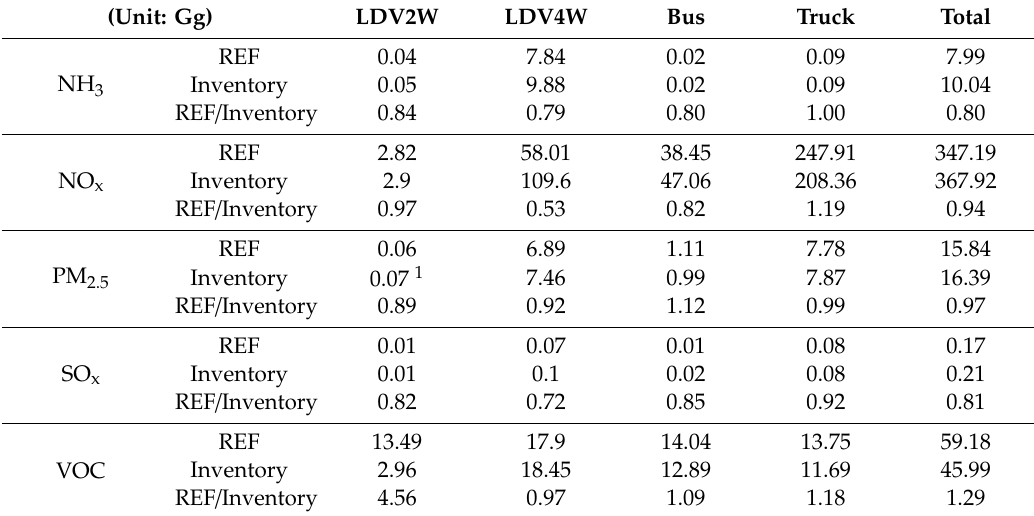
Table 4. Comparison of emissions from the national inventory and those from GCAM-Korea (2015).